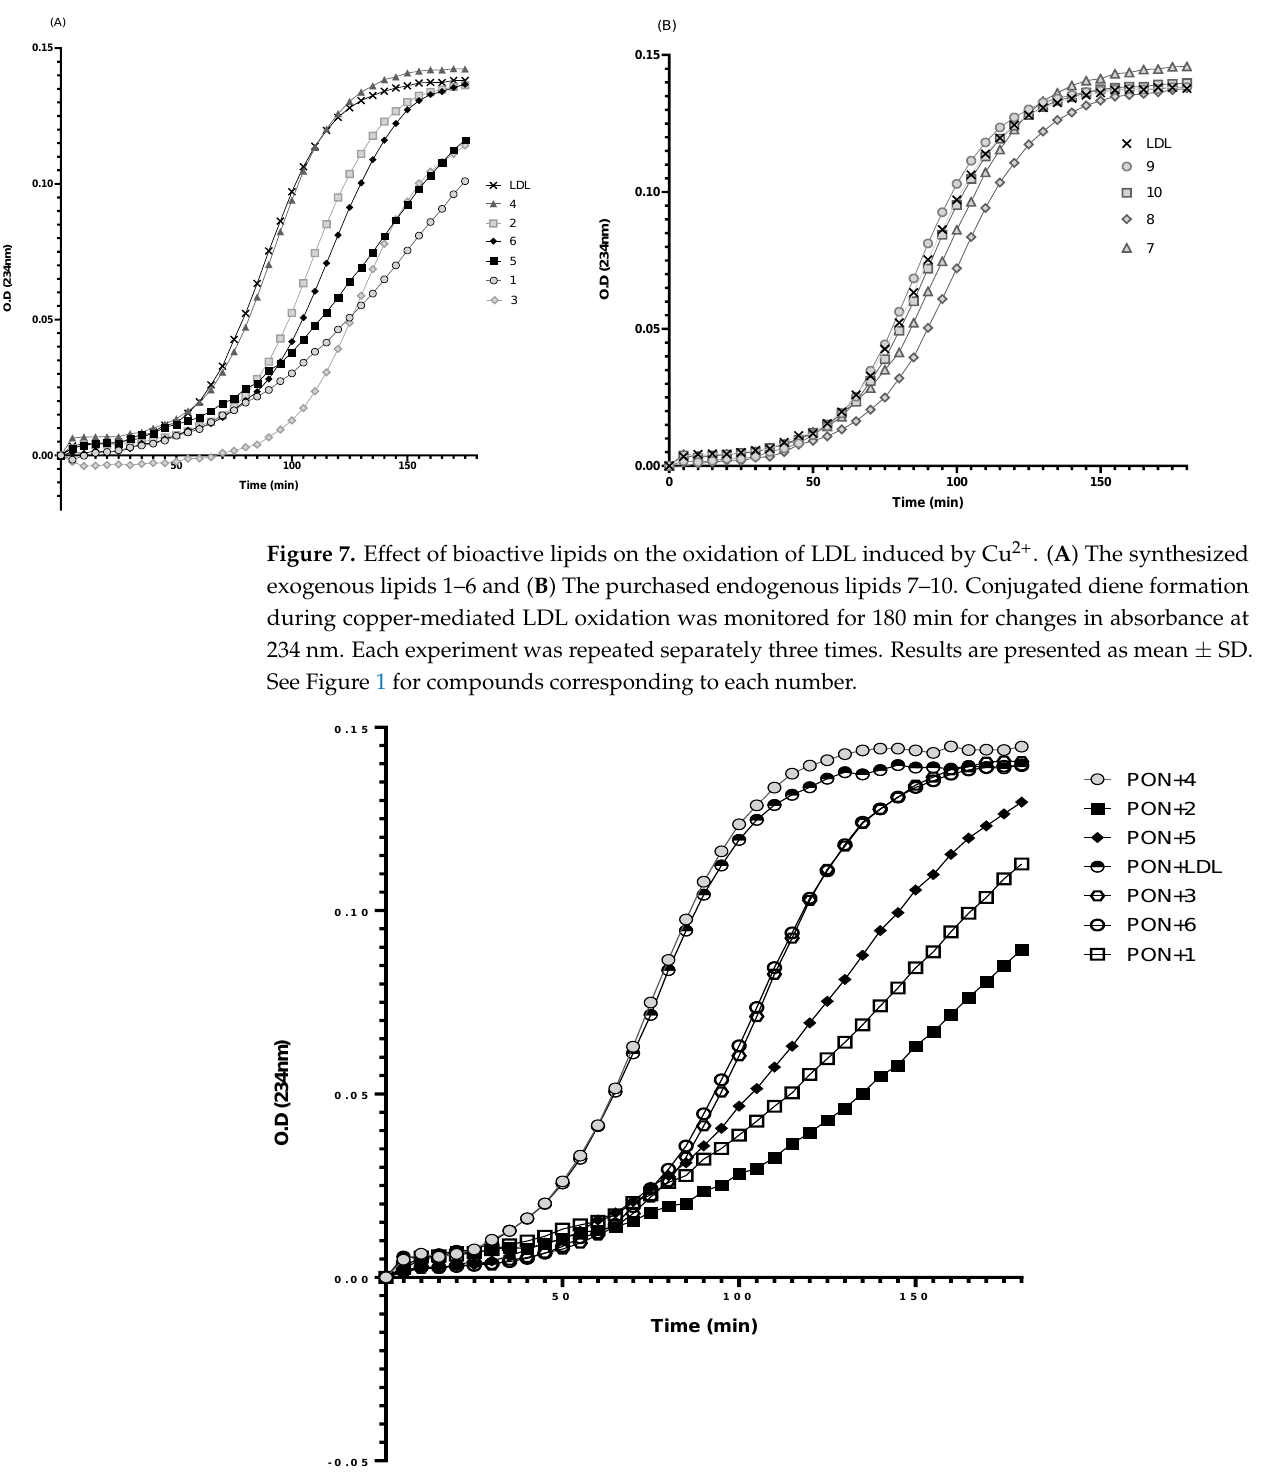
Figure 8. Effect of rePON1 with the exogenous bioactive lipids on the oxidation of LDL induced by Cu 2+ . Conjugated diene formation during copper-mediated LDL oxidation was monitored for 180 min for changes in absorbance at 234 nm. Each experiment was repeated separately at least three times. Results are presented as mean ± SD. See Figure 1 for compounds corresponding to each number. Table 1. Effect of the synthesized lipids on lag time, rate constant of the reaction propagation (K), and % inhibition of LDL oxidation. See Figure 1 for compounds corresponding to each number.